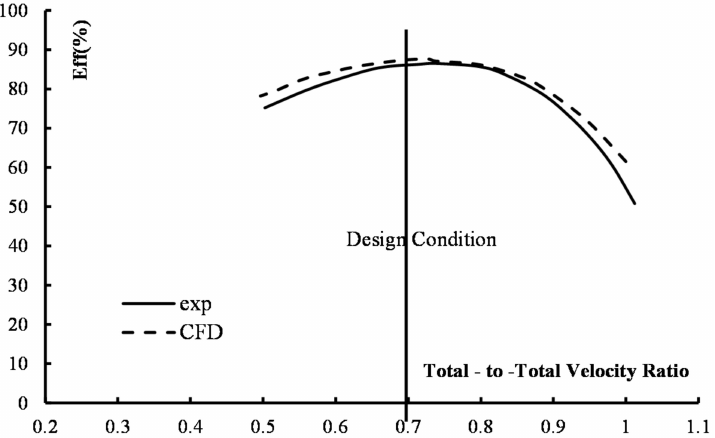
Figure 12. Comparison between experiments and CFD for the Ricardo RI turbine